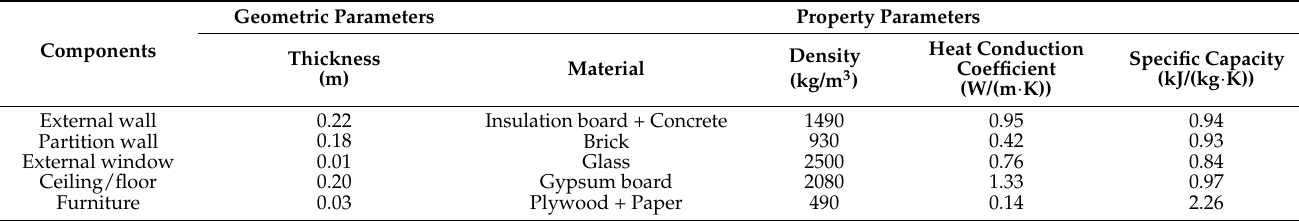
Table 4. Parameters of one typical office zone.